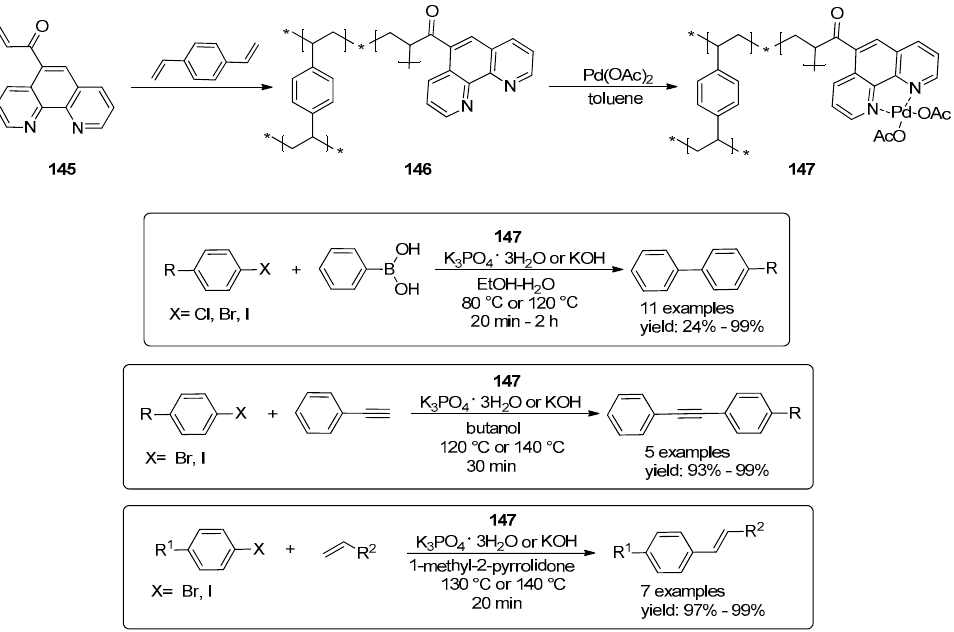
Scheme 54. Synthesis of SWCNT-PAMAM-Pd hybrids 144a – b-Pd and their use in cross coupling reactions.